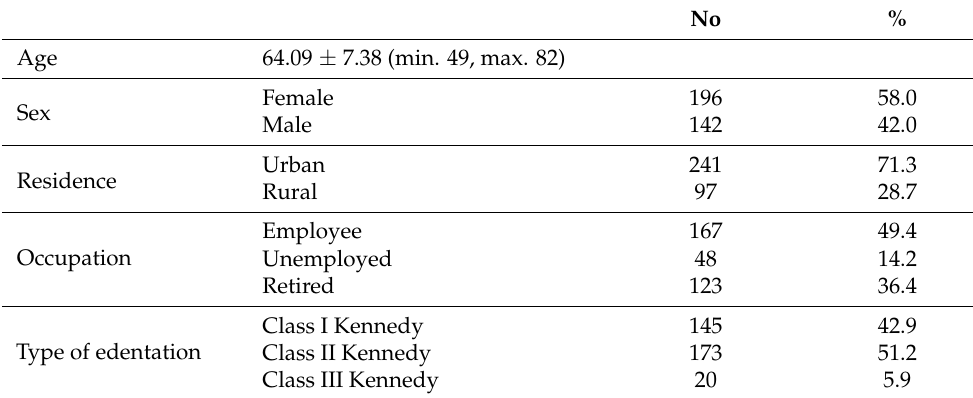
Table 1. Demographic characteristics of the study